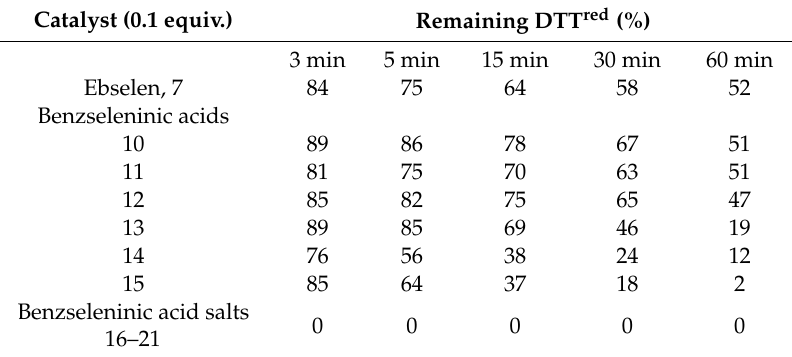
Table 1. Results of the antioxidant activity measurement.